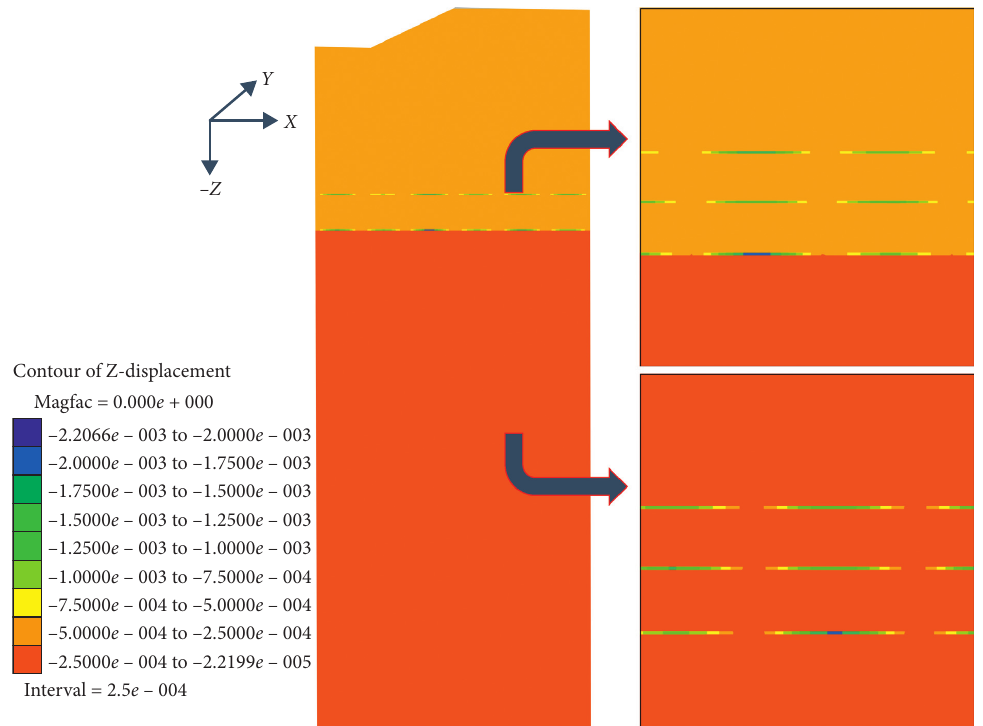
Figure 7: Cloud chart of vertical displacement for the model after